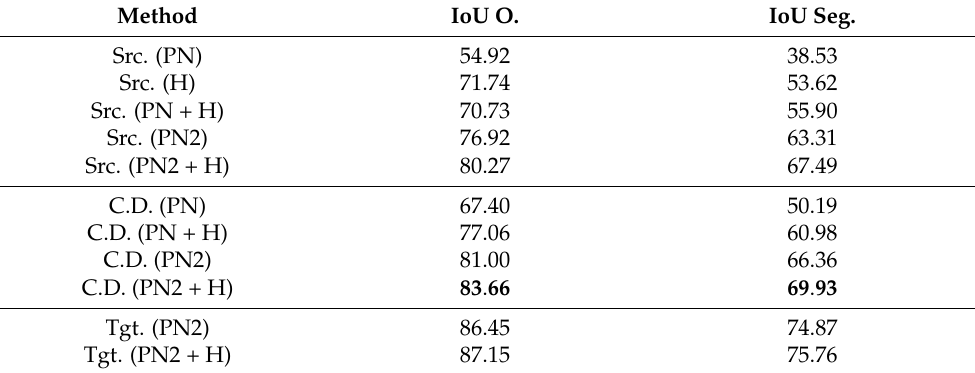
Table 4. The overall (IoU O.) and average IoU over height segments (IoU Seg.) of the point cloud semantic segmentation methods averaged over the 12 cross-dataset scenarios. We compare our cross- dataset semantic segmentation methods (denoted as C.D. ) with the supervised baselines trained only on the labelled source training set (denoted as Src. ) and the supervised baselines trained only on the labelled target training set (denoted as Tgt. ). Both Src. and Tgt. baselines are evaluated on the target validation set. All the experiments are performed on the three different training and validation splits for each cross-dataset scenario and we highlight the best results (in bold).